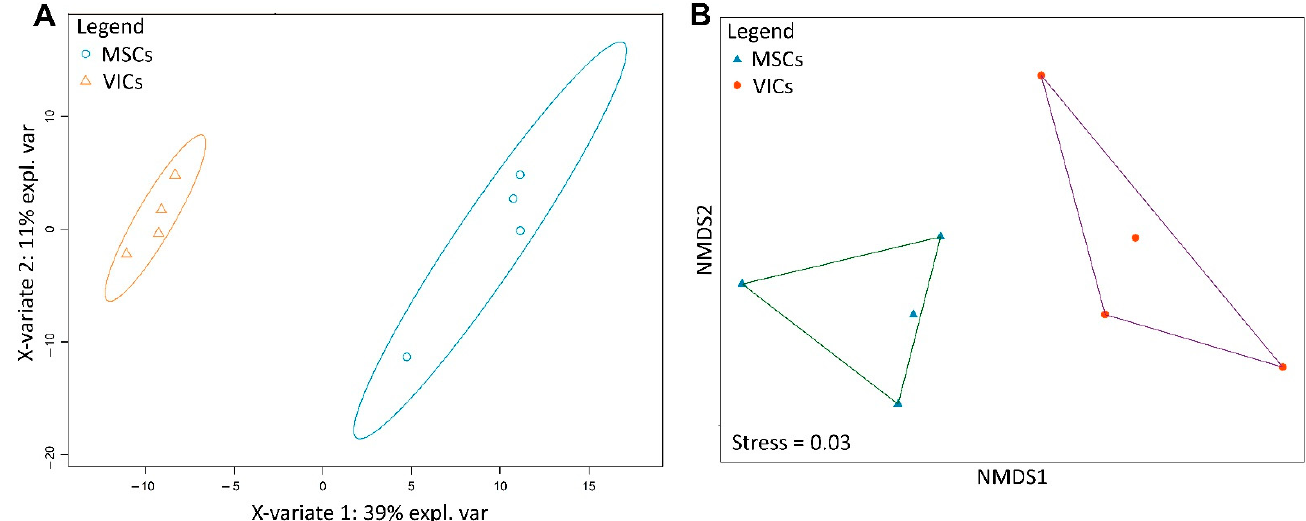
Figure 3. Ordination plots illustrating the differences in the metabolomic profiles among mesenchymal stem cells (MSCs) of adipose tissue and aortic valve interstitial cells VICs after osteogenic differentiation induced by a standard osteogenic medium or osteogenic medium, and transduction with Notch intracellular domain (NICD). (A) Partial least squares discriminant analysis (PLS-DA) scores plot. ( B ) Non-metric multidimensional scaling (nMDS) plot. The Kruskal stress value indicating the quality of ordination.